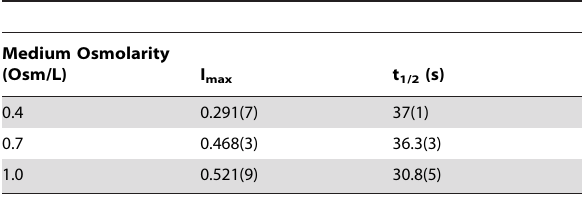
Table 1. Parameters determined from non-linear fits of calcein